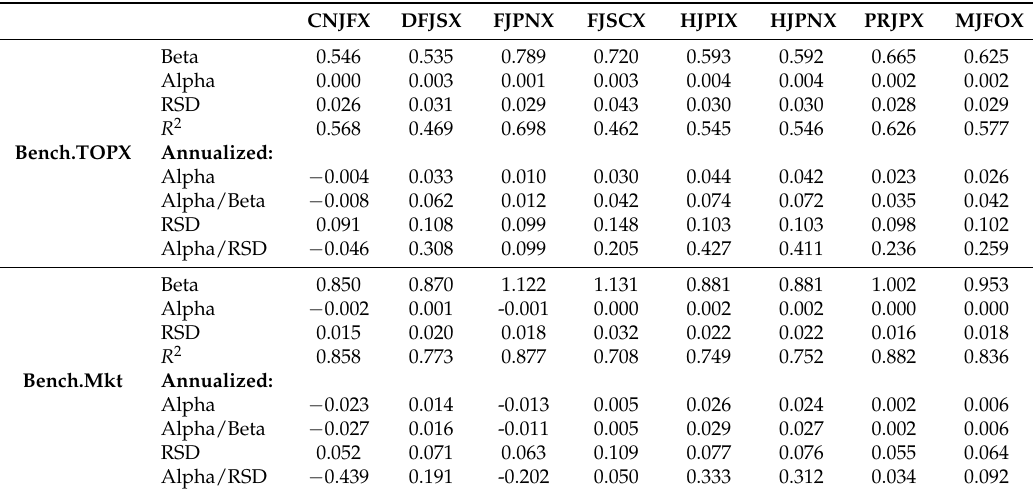
Table 4. Regression of mutual funds’ excess returns with TOPX and Mkt as benchmarks from April